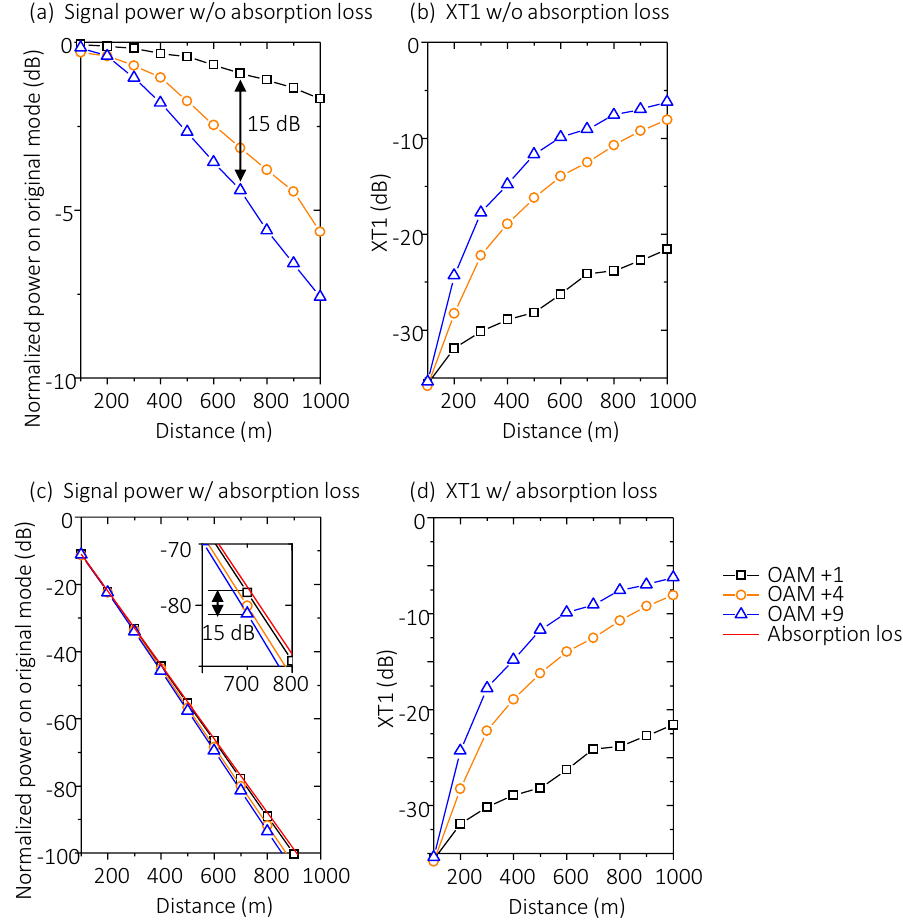
Figure 6. Effects of varying the OAM order on normalized power distribution on different OAM modes. ( a ) The received signal power on the transmitted mode order, and ( b ) XT1 for 1-km link with C f = 0.5 THz, and w 0 = 0.1 m at the transmitter side without considering the atmospheric absorption. ( c , d ) are the corresponding signal power and XT1 of the same link with the atmospheric absorption. The inset in ( c ) shows the signal power at a distance from 600 to 800 m. Different curves are close to each other and thus it might be hard to distinguish the power distribution on different OAM orders. Moreover, comparing the curves in ( b , d ) shows that the crosstalk performance seems to be almost the same even when the atmospheric absorption is not considered. The legends in ( a – d ) are the same. Scales in y-axis in ( a – d ) are